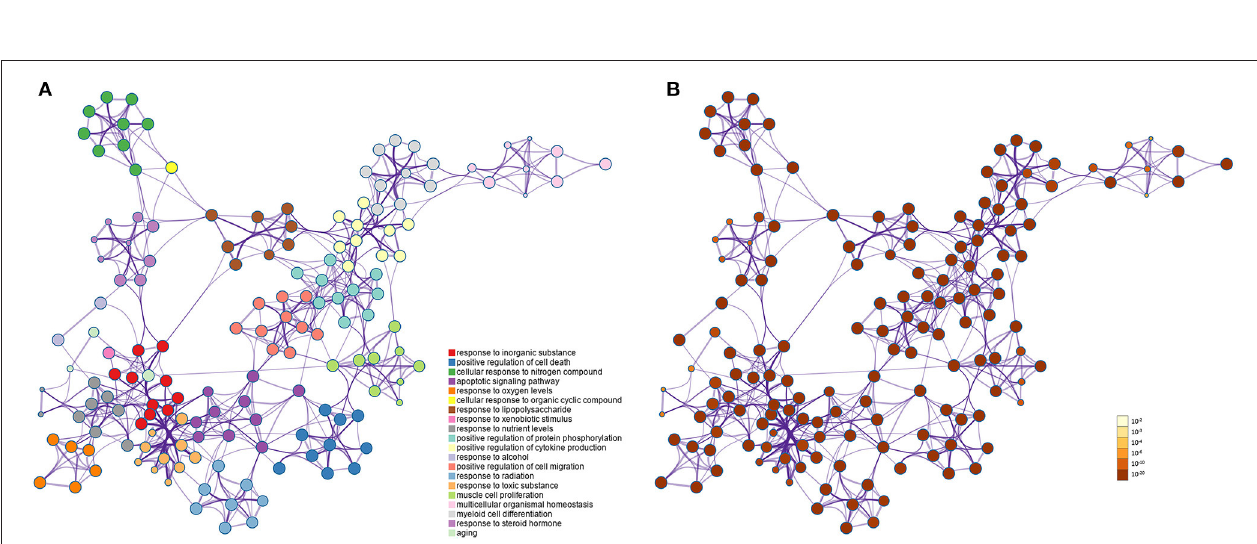
FIGURE 4 | GO enrichment network map of potential therapeutic targets. (A) Colored by cluster-ID, the same color represents participation in similar functions. (B) Colored by p -value, the picture’s colors all indicate that p <